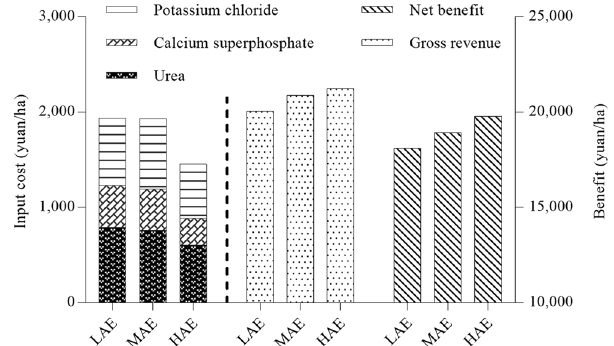
Figure 4. Estimated input costs and benefits of fertilization in rice cultivation at low (LAE), medium (MAE), and high agronomic efficiency (HAE). The price of rice was fixed at 2.7 RMB yuan/kg; prices for N, P 2 O 5 , and